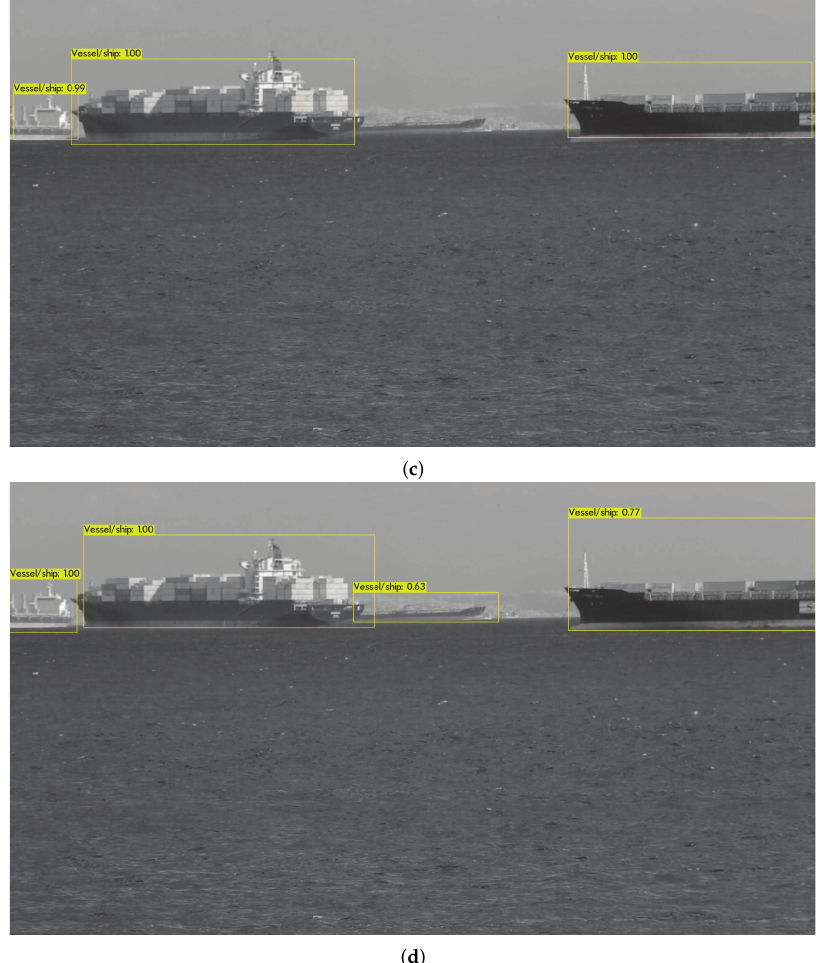
Figure 7. IoU for each recognition model in black-and-white image. ( a ) Model 1. ( b ) Model 2. ( c ) Model 3. ( d ) Model